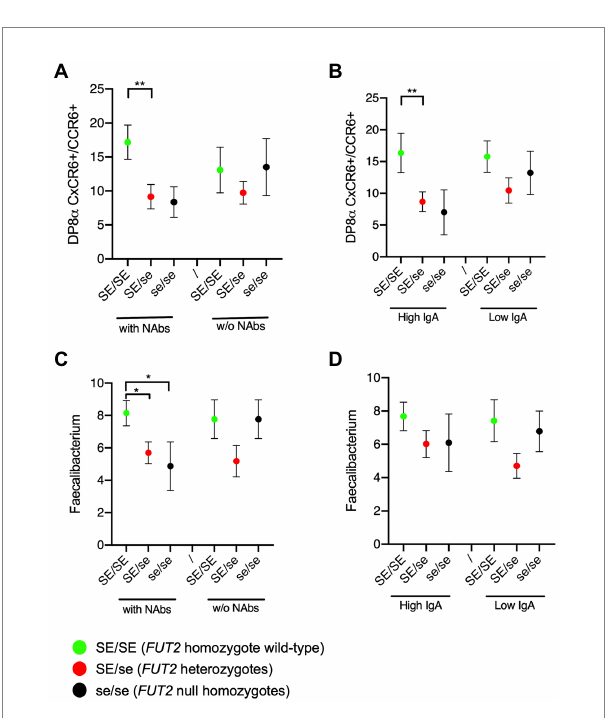
FIGURE 3 Tripartite relationships between the FUT2 status, the anti-RVA status and either the Treg cells or the Faecalibacterium prausnitzii frequency. (A) Frequencies of circulating DP8 α Treg cells (per 10.000 total CD3+ cells) according to the FUT2 status and the presence or absence of NAbs; (B) or the high versus low IgA titers; (C) Relative abundance of Faecalibacterium based on 16S metabarcoding according to the FUT2 status and the presence or absence of NAbs; (D) or the high versus low IgA titers. Comparisons were performed by two-sided Mann–Whitney test: * p < 0.05; ** p < 0.01. SE/SE = FUT2 homozygote wild-type (green symbols); SE/se = FUT2 heterozygotes (red symbols); se/se = FUT2 null homozygotes (black